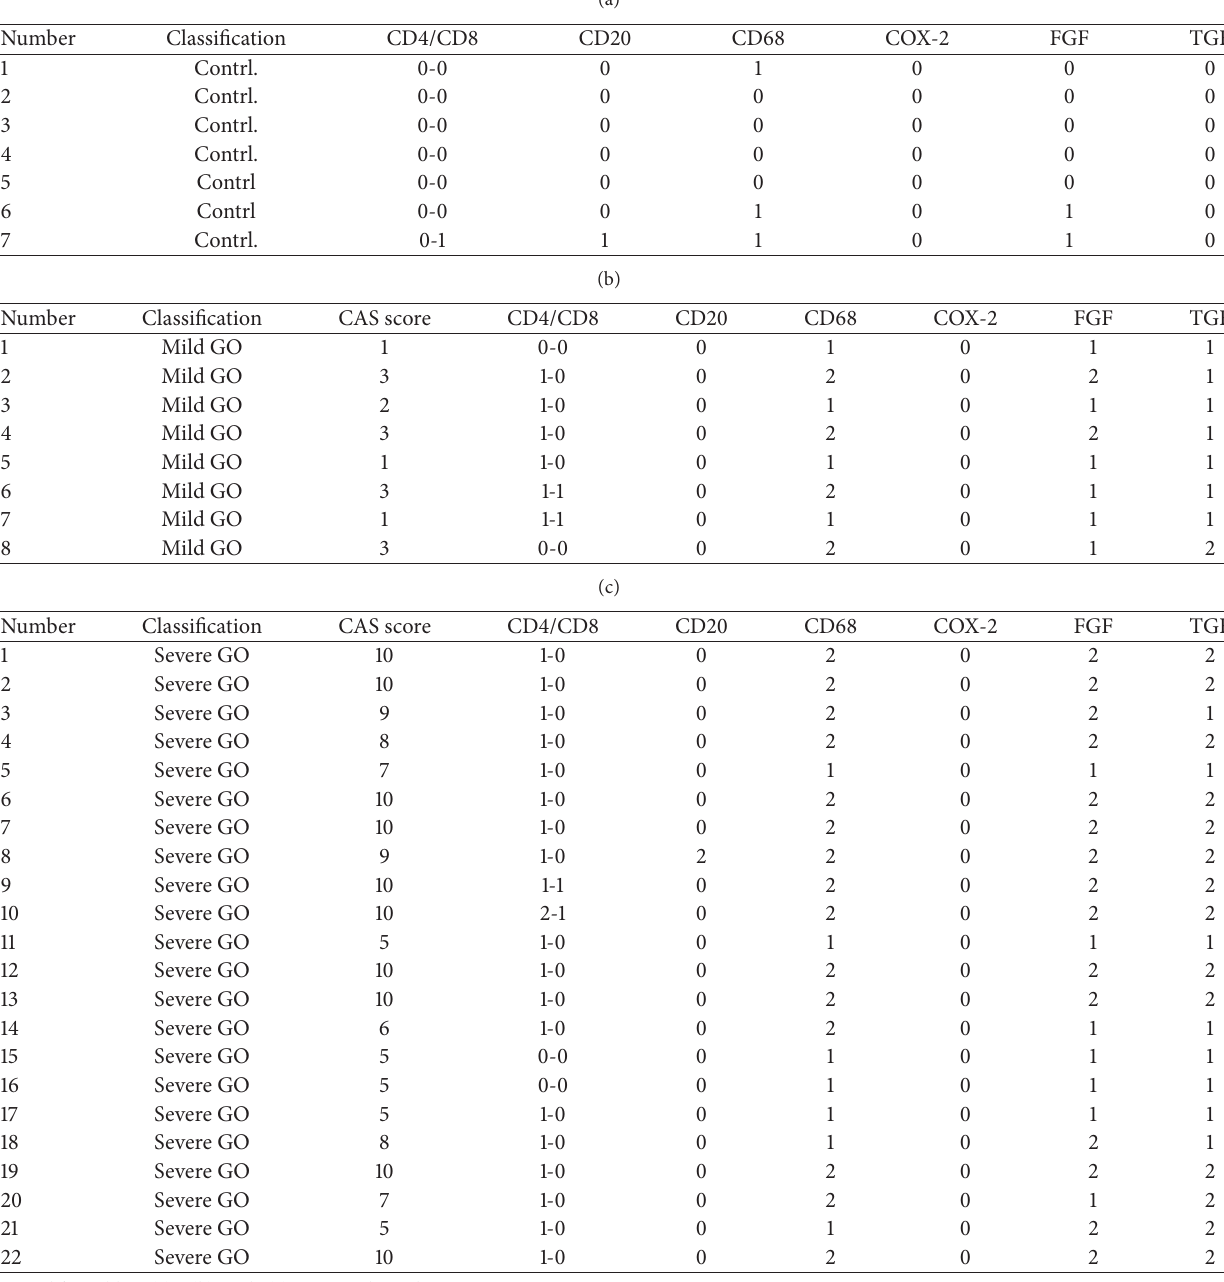
Table 2: Immunohistochemical evaluation grading score for CD4/CD8, CD20, and CD68 cells and FGF- 𝛽 , COX2, and TGF- 𝛽 of each specimen.(a)Expressionoftheexaminedmarkersinthecontrolgroup,(b)expressionofthemarkersinthegroupofmildGraves’orbitopathy, and (c) expression of the markers in the group of severe Graves’